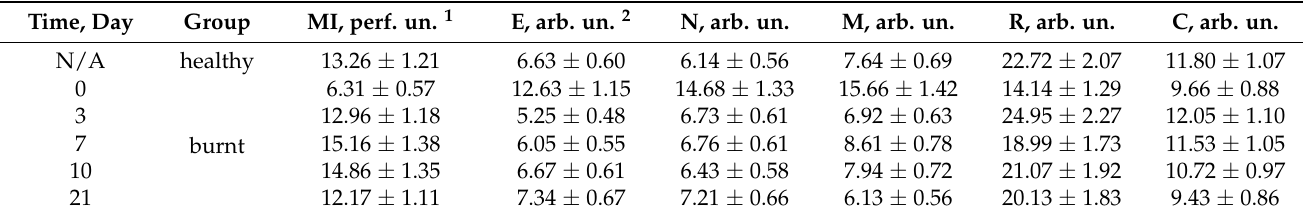
Table 9. Results of Doppler flowmetry of blood microcirculation in a burn wound under the action of bacterial cellulose wound dressings ( p < 0.001).